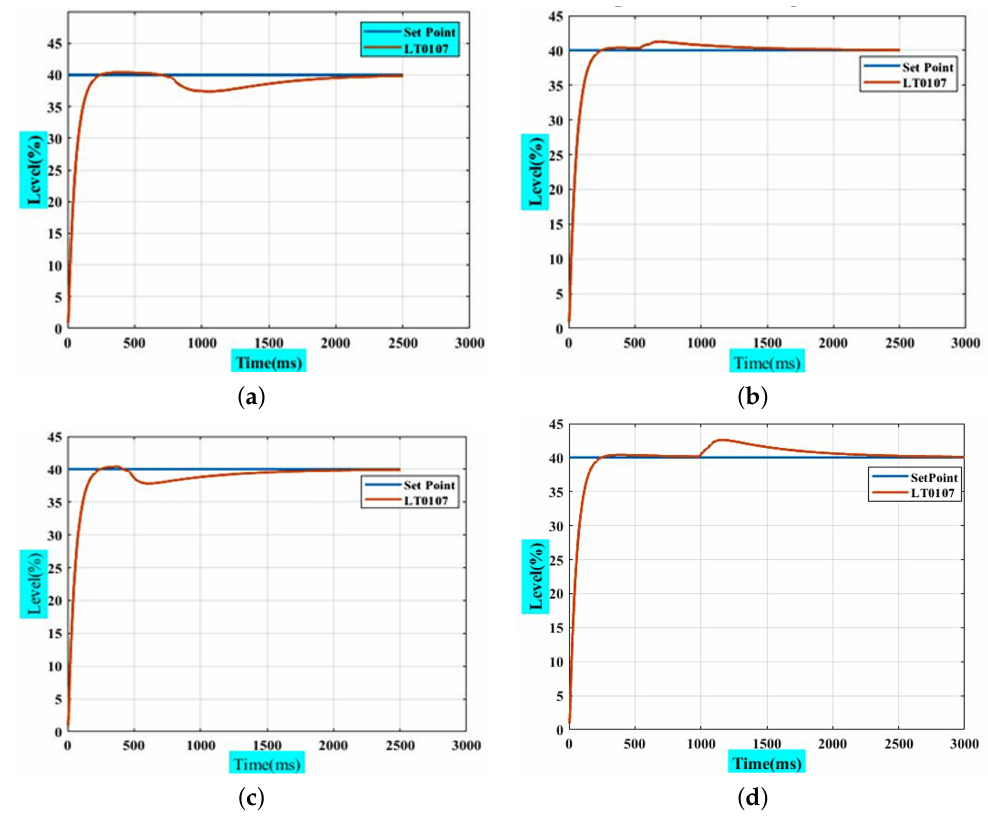
Figure 10. Response of system with closed-loop auto-tuning PID controller in the case of several values of m2 and yi; ( a ) decrease m2 to 250 kmole/h; ( b ) increase m2 to 1000 kmole/h; ( c ) increase yi to 100%; ( d ) decrease yi to